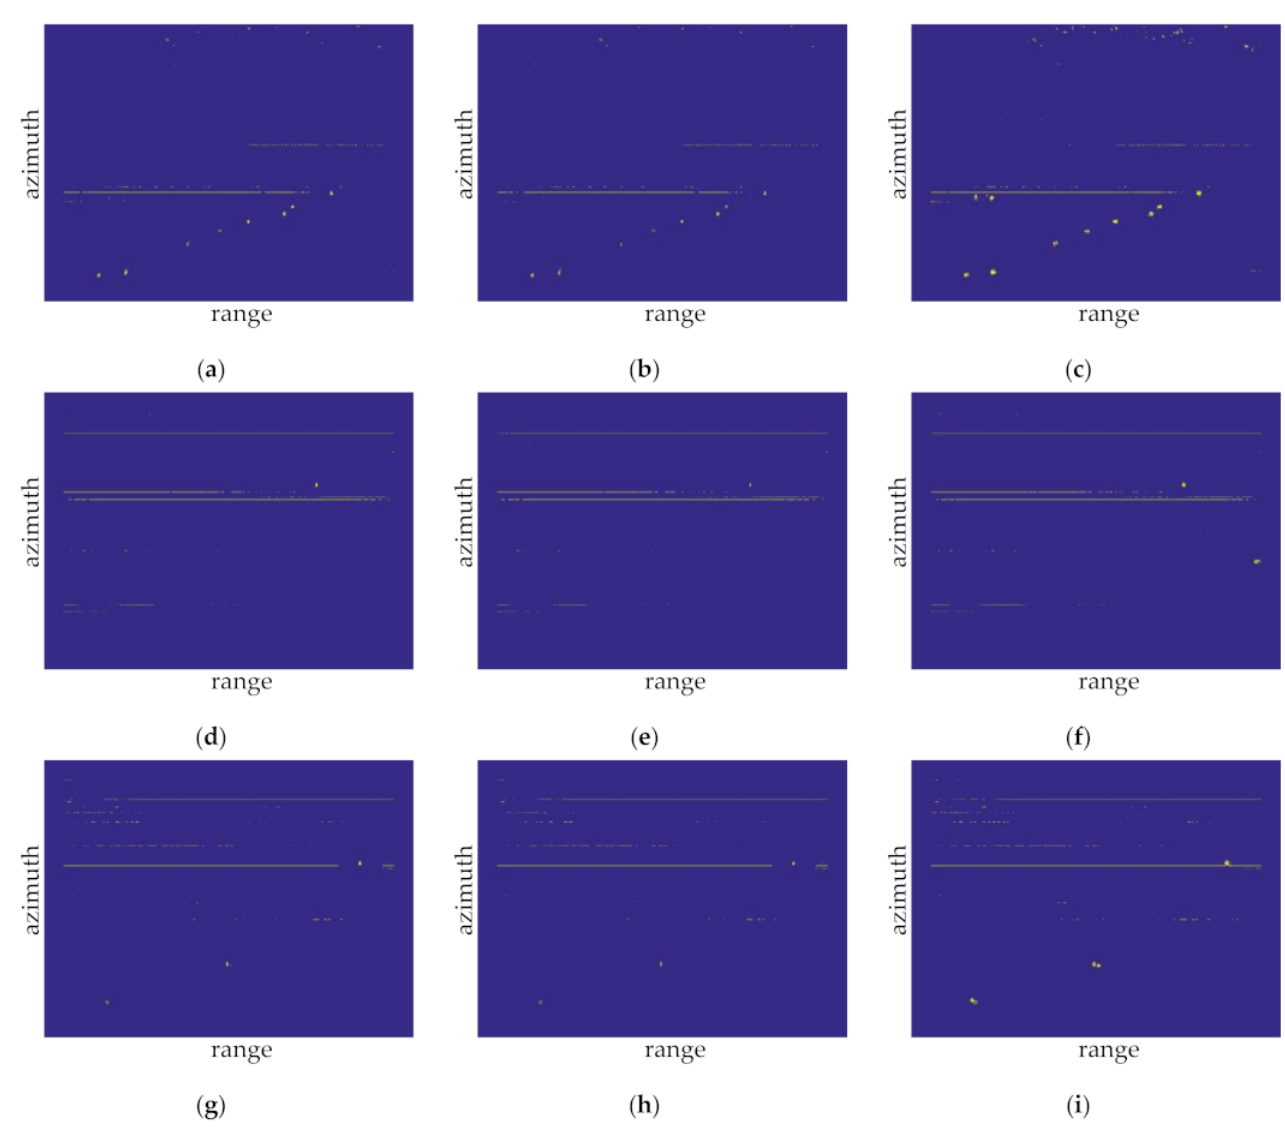
Figure 17. Detection results of the samples for the CA-CFAR, GOCA-CFAR, and SOCA-CFAR algorithms in distant water: ( a ) the CA-CFAR detection results of sample 4; ( b ) the GOCA-CFAR detection results of sample 4; ( c ) the SOCA-CFAR detection results of sample 4; ( d ) the CA-CFAR detection results of sample 5; ( e ) the GOCA-CFAR detection results of sample 5; ( f ) the SOCA-CFAR detection results of sample 5; ( g ) the CA-CFAR detection results of sample 6; ( h ) the GOCA-CFAR detection results of sample 6; and ( i ) the SOCA-CFAR detection results of sample